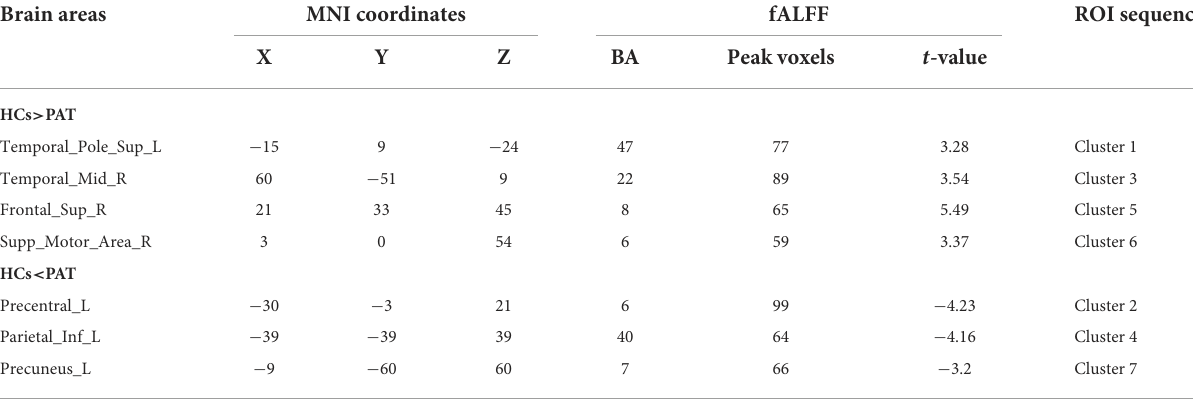
TABLE 2 Brain regions with significant differences in fALFF between PAT and HC groups. Brain areas